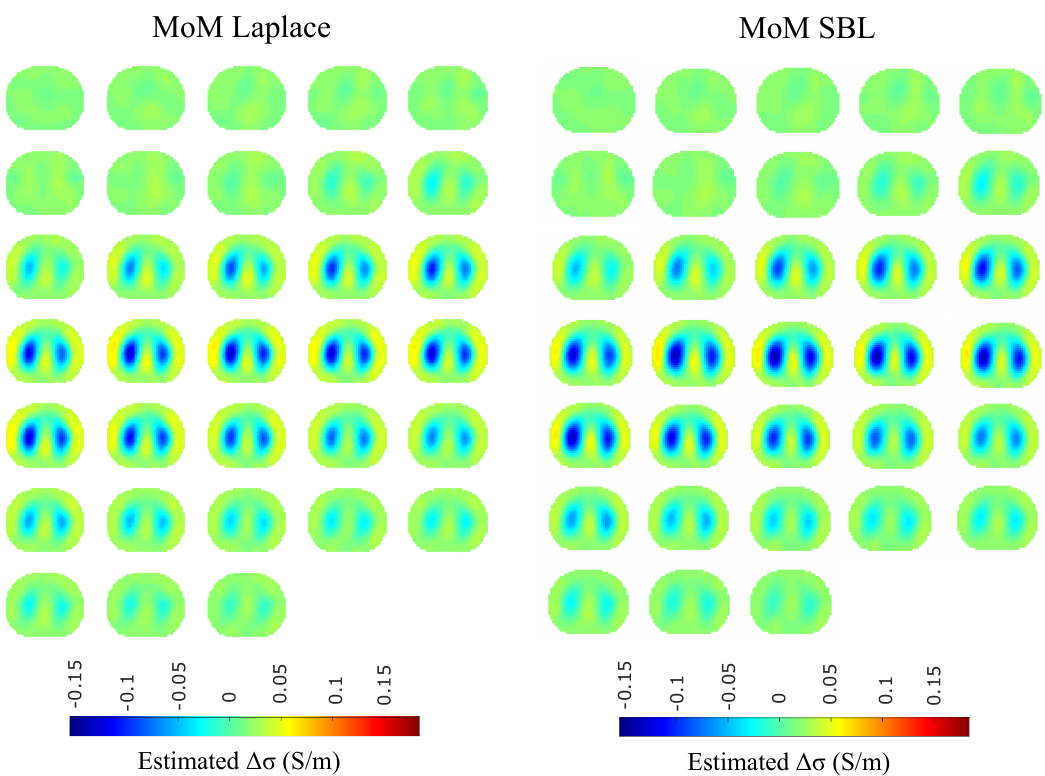
Figure 17. Single–breath in vivo results using the difference of absolute images and multiple priors non-linear difference imaging approaches.